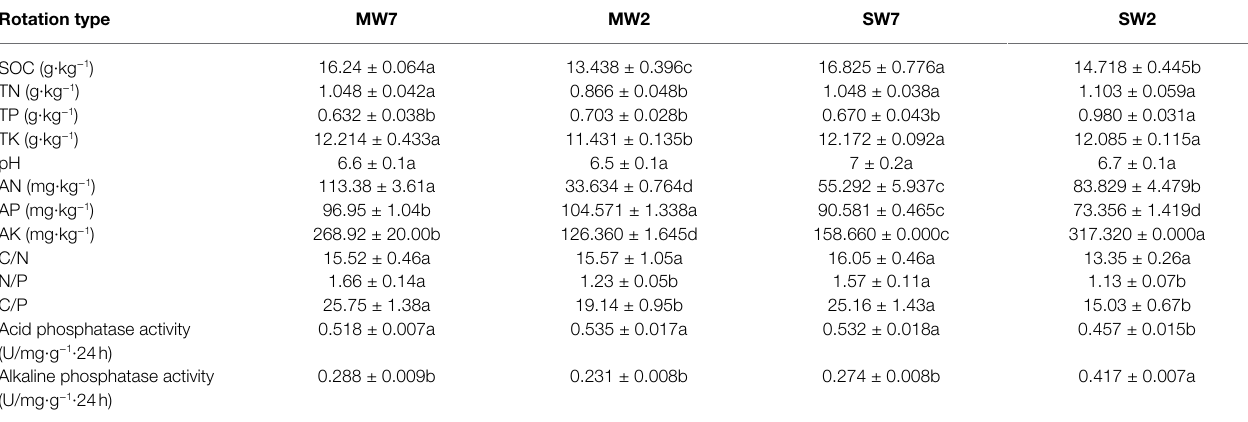
TABLE 1 | Soil properties related to crop rotations. Rotation